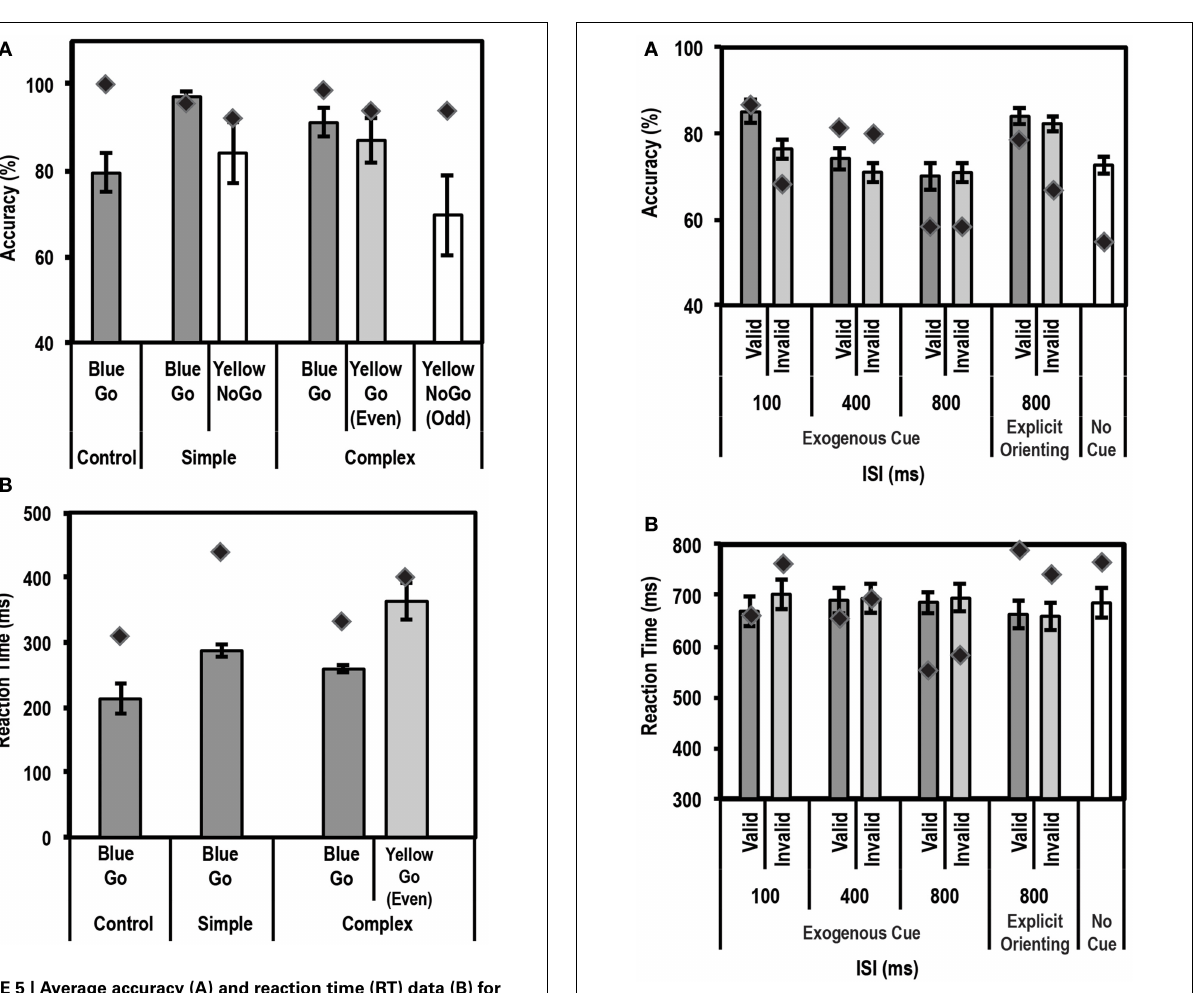
3 . 22; p = 0 . 0053]. No such effect was seen for the 400 ms, and either of the 800 ms ISI conditions (implicit and explicitly